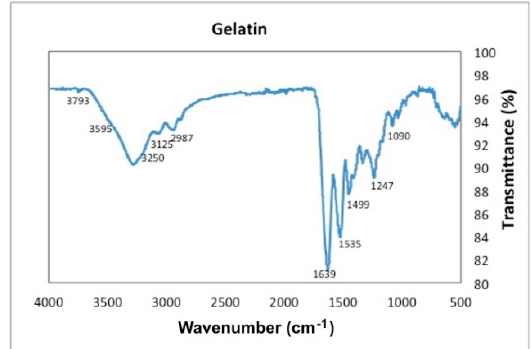
Figure 8. Transmittance as a function of wavenumber for gelatin.